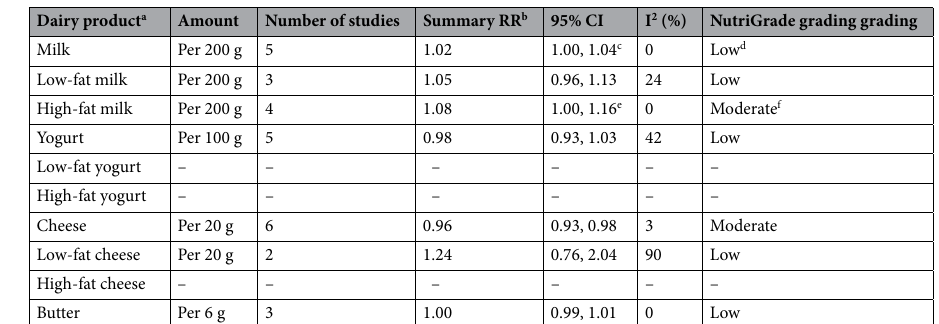
Table 3. Linear dose–response meta-analysis on dairy product subgroups and risk of coronary heart disease, and NutriGrade meta-evidence grading. CI confidence interval; RR risk ratio. a Yogurt defined as yogurt/ other soured milk products. b Scoring for effects size was based on summary RR estimates from dose–response meta-analysis. c P = 0.12. d There is low confidence in the effect estimate; further research will provide important evidence on the confidence and likely change the effect estimate. e P = 0.04. f There is moderate confidence in the effect estimate, further research could add evidence on the confidence and may change the effect estimate.